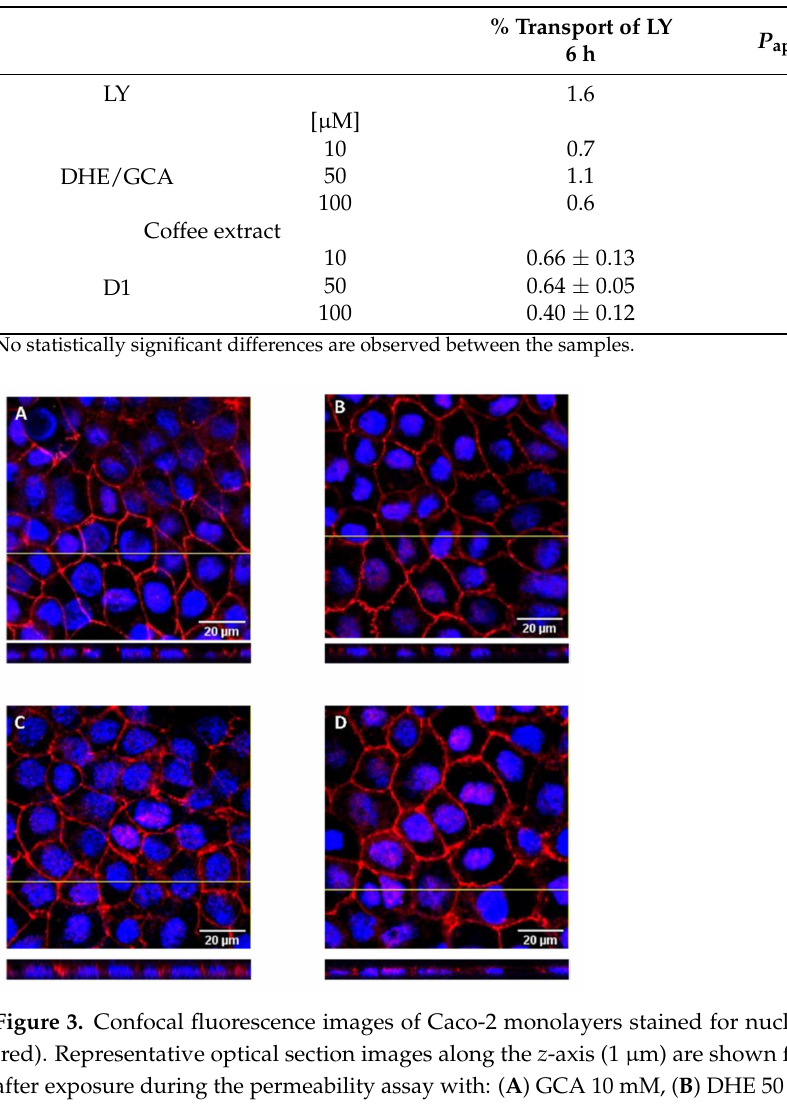
Table 2. Amount of LY transported and corresponding permeability coefficient in permeability assays through Caco-2 monolayers with a single time point assay of 6 h. Effect of increasing DHE concentrations (10, 50 and 100 µ M) emulsified by GCA (10 mM), in the absence and presence of coffee extract D1, n = 2.